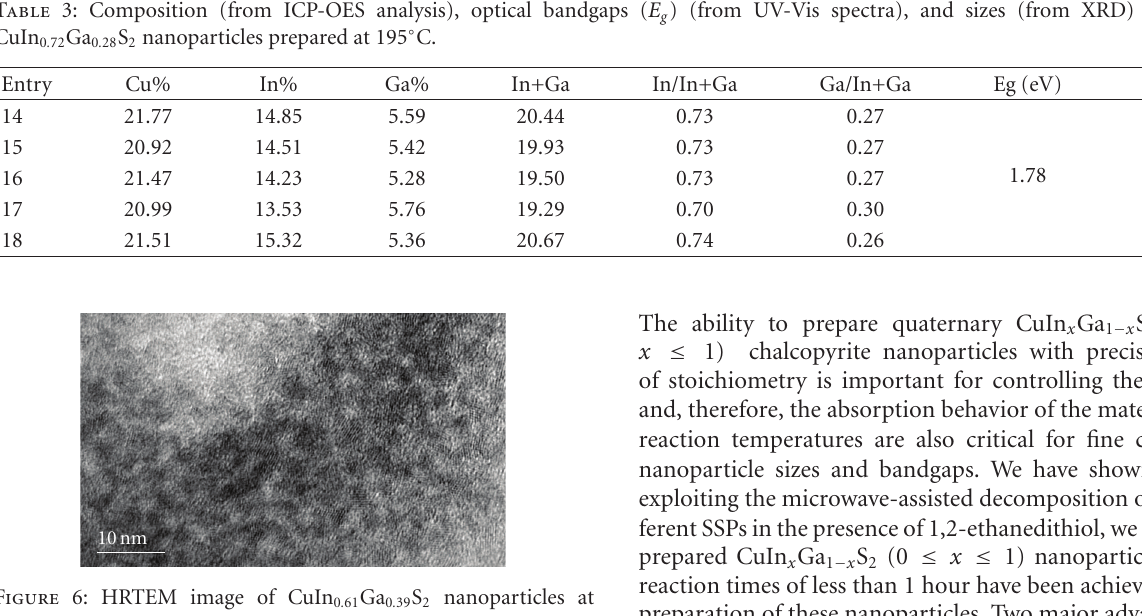
Table 3: Composition (from ICP-OES analysis), optical bandgaps ( E g ) (from UV-Vis spectra), and sizes (from XRD) of soluble